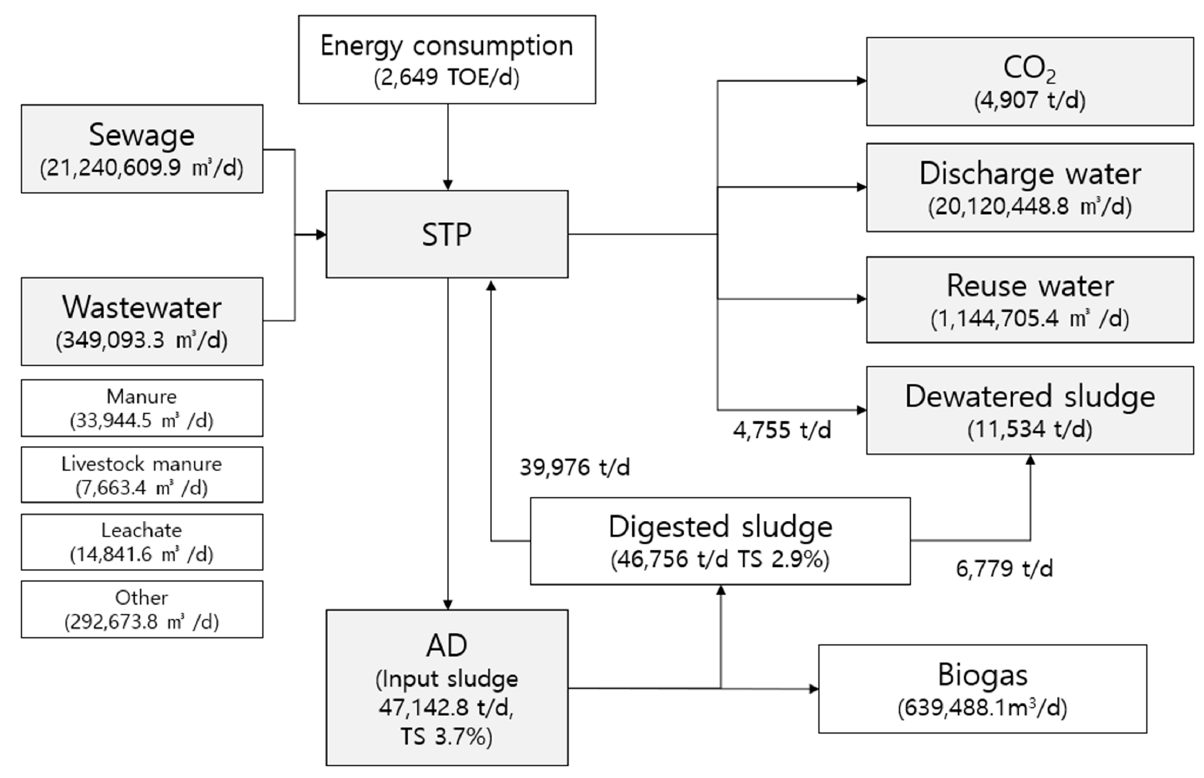
Figure 1. SS flow in STP in Korea. Energy consumption refers to the total energy consumption of STP, and CO 2 refers to energy consumption and the amount of CO 2 emitted from STP. The amount of biogas refers to the amount of unrefined generation.